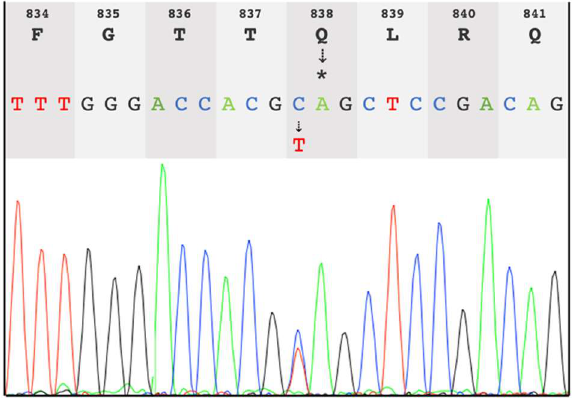
Figure 1. Sanger chromatogram showing the de novo heterozygous stop-gain variant in MYRF (c.2512C>T; p.Q838*) in the study